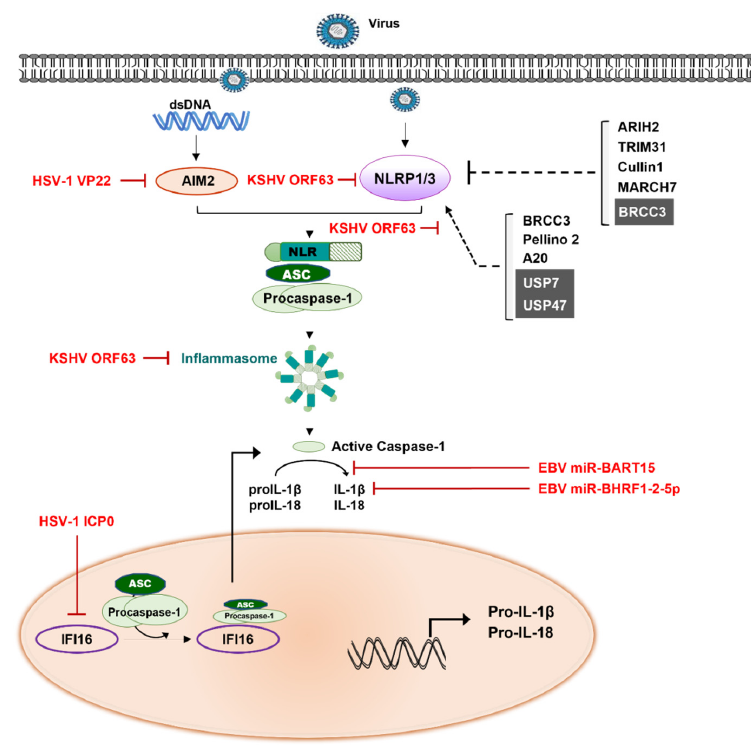
Figure 3. Herpesviruses-associated escape modes in Inflammasome mediated signaling cascades. The NLRP3 interacts with apoptosis-associated speck-like protein containing a CARD (ASC) via its pyrin domain (PYD) and the CARD of ASC recruits the CARD of pro-caspase-1 to generate NLRP3-ACS-pro-caspase-1 complex (also called NLRP3 inflammasome). The words of red color indicate herpesviruses proteins. The gray boxes represent cellular DUBs. Solid lines represent inflammatory signaling pathway. The dashed lines indicate effects of cellular E3 ubiquitin ligases (or DUBs) on molecules in inflammatory signaling